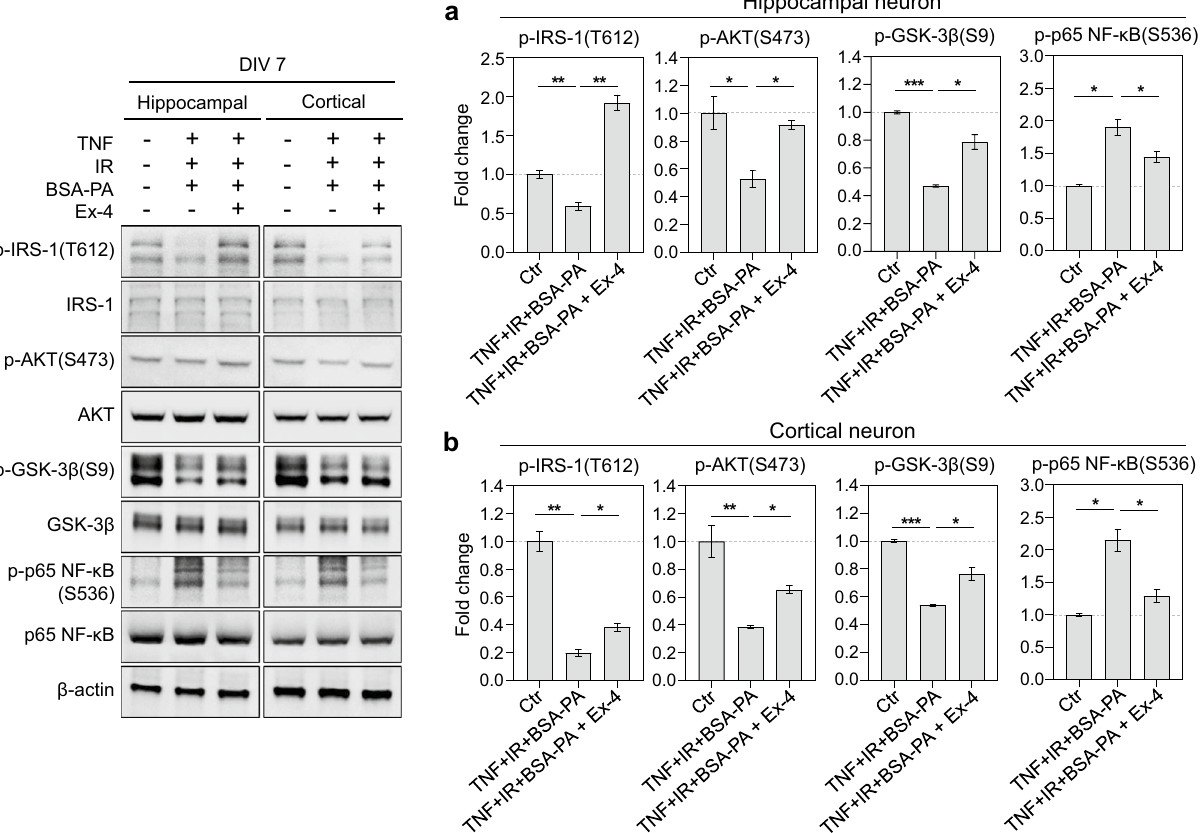
Figure 3. Exendin-4 regulates the phosphorylation of proteins related to insulin signaling and neuroinflammation in in vitro neurons in metabolic imbalance conditions. ( a ) The measurement of phosphorylated and native protein levels after treating with a combination of inducers of metabolic imbalances such as TNF-α, insulin, glucose, palmitate, and a therapeutic agent exendin-4 into primary hippocampal neurons of mice at DIV 7. ( b ) The measurement of phosphorylated and native protein levels after treating with a combination of inducers of metabolic imbalances such as TNF-α, insulin, glucose, palmitate, and a therapeutic agent exendin-4 into mouse primary cortical neurons at DIV 7. Data information: Cont.: control, TNF: 25 ng/ ml TNF-α, IR: insulin resistance (treatment of 100 nM insulin and 4.5 g/L d-glucose), BSA-PA: 50 μM BSA- conjugated palmitate, Ex-4: 10 nM exendin-4. Data are expressed as the group mean ± standard error of the mean. Data are expressed from three independent experiments in triplicate. Their native protein normalized a phosphorylated protein, and the corresponding value was expressed as a fold change in the histogram. Statistical analyses examined the relative significance between each group (unpaired two-tail t -test with Welch’s correction). *P < 0.05, **P < 0.01, and ***P <